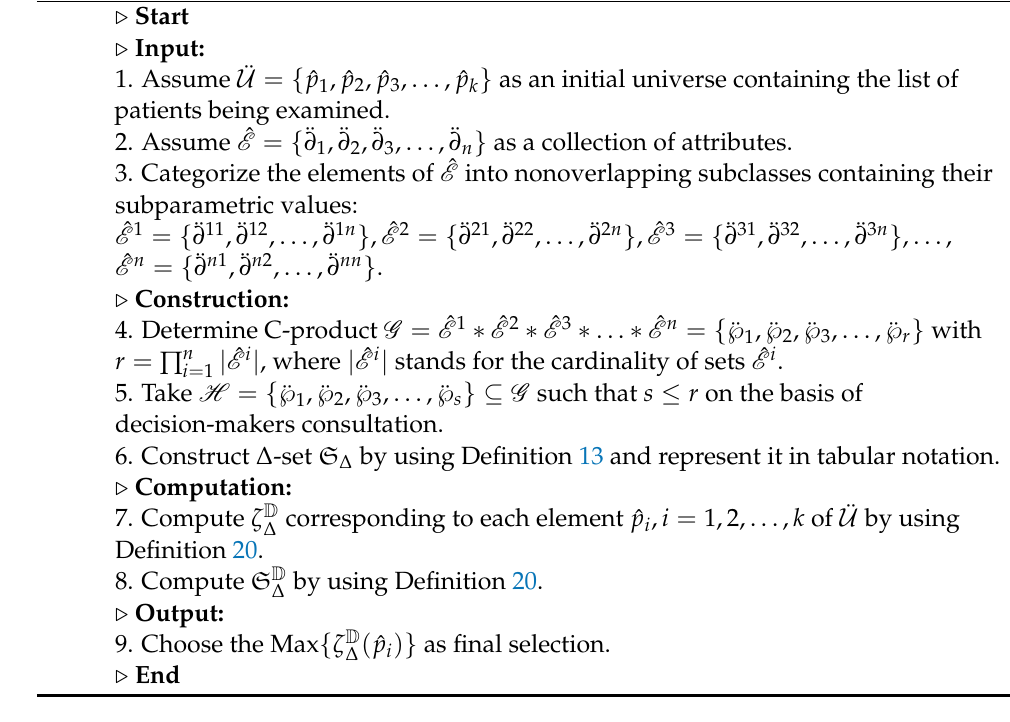
Algorithm 1: Steps for the analysis of heart-related diseases based on ∆ -set.